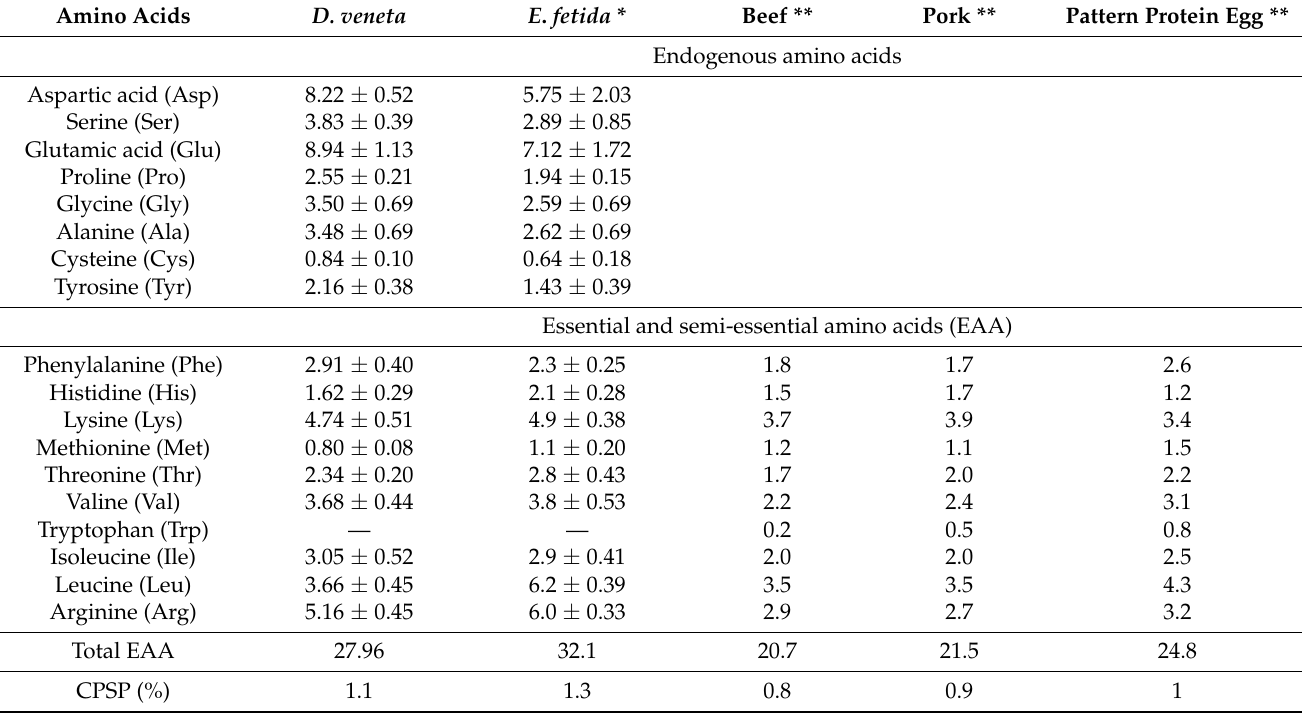
Table 2. Content of amino acids (% DM) in the biomass of D. veneta cultivated on kitchen